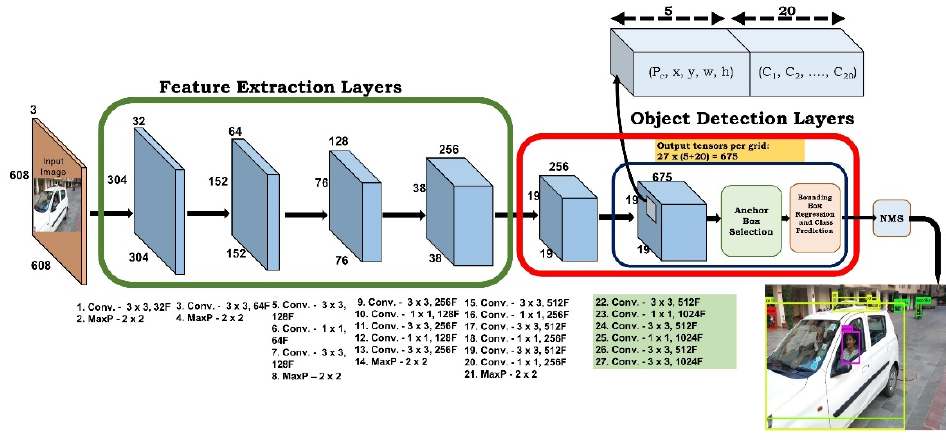
Figure 7. Architecture of proposed model.